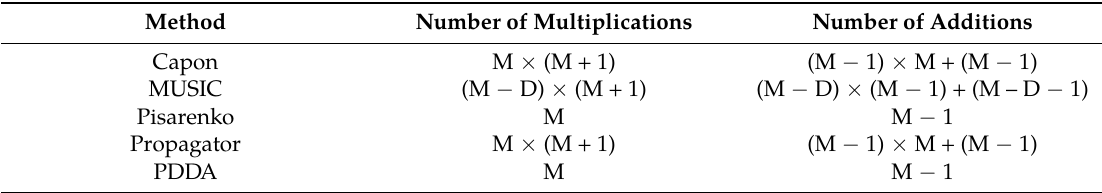
Table 3. Showing the computational operations required to construct the spatial spectrum for the PDDA and popular AOA methods.